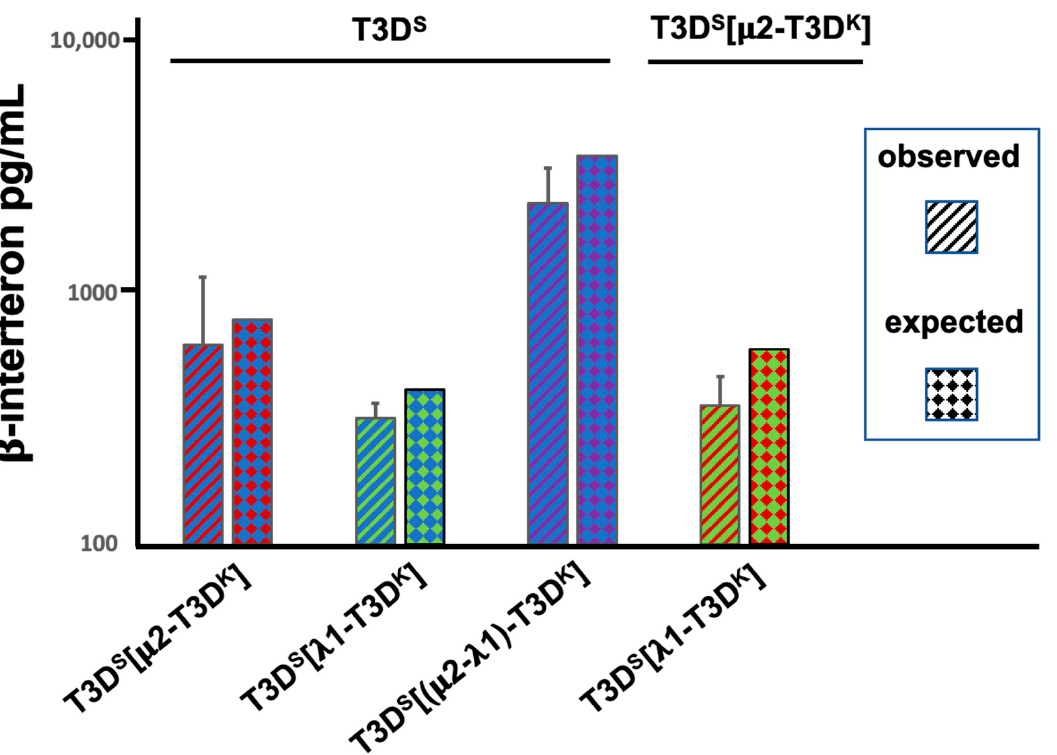
Figure 2. Interferon induction upon co-infection. L929 cells were simultaneously infected with two different viruses at a MOI of 10 TCID 50 units per cell for each virus, as indicated at the top and bottom of the graph. The tissue culture medium was recovered 15 h post-infection and directly used in the commercial ELISA for β -interferon, as in Figure 1. Results are presented as the average of 4 independent biological replicates with error bars representing the standard error of the mean. The “expected” value presented is the mean of the value for each virus in the pair, as obtained in Figure 1A.